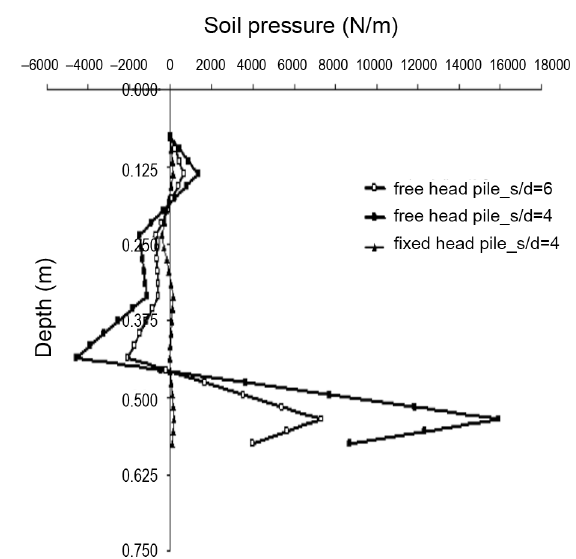
Fig. 12. The overall relative soil surface displacements